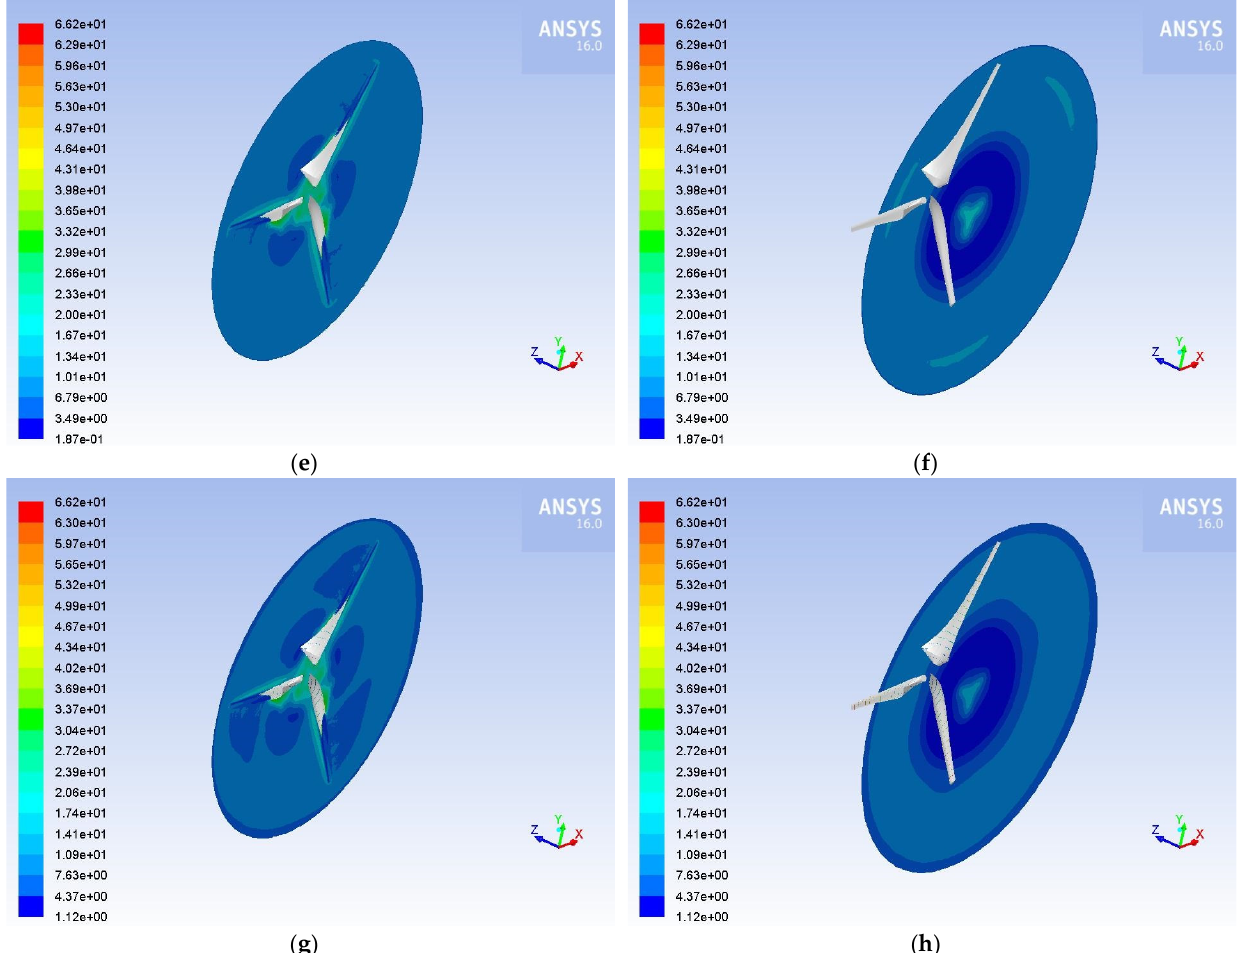
Figure 5. Velocity contours at wind speed of 10m·s − 1 : ( a ) 0 m from the rotor, Q = 0%; ( b ) 15 m from the rotor, Q = 0%; ( c ) 0 m from the rotor, Q = 1%; ( d ) 15 m from the rotor, Q = 1%; ( e ) 0 m from the rotor, Q = 5%; ( f ) 15 m from the rotor, Q = 5%; ( g ) 0 m from the rotor, Q = 10%; ( h ) 15 m from the rotor, Q = 10%.